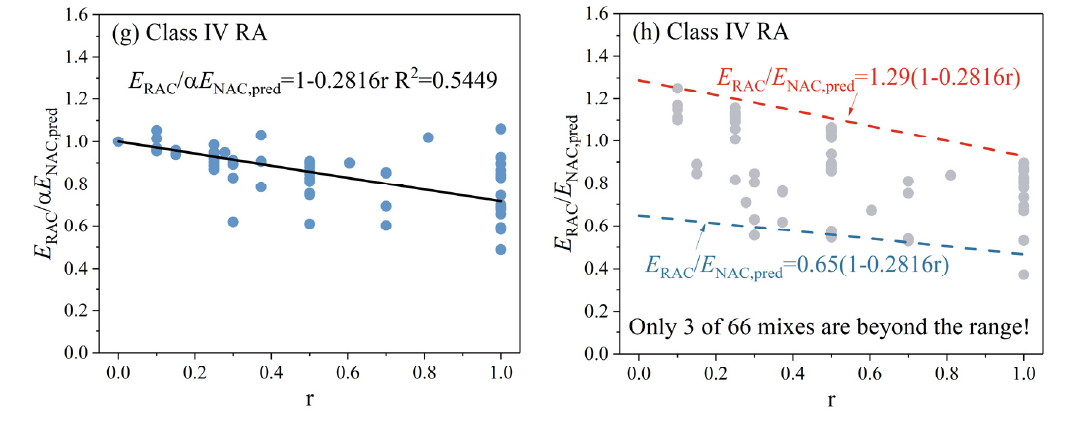
Figure 5. Relationships between E RAC / α E NAC,pred , E RAC / E NAC,pred and r of RAC [21,22,28–167,169–174]. ( a ) Relationship between E RAC / α E NAC,pred and r of Class I RAC; ( b ) relationship between E RAC / E NAC,pred and r of Class I RAC; ( c ) relationship between E RAC / α E NAC,pred and r of Class II RAC; ( d ) relationship between E RAC / E NAC,pred and r of Class II RAC; ( e ) relationship between E RAC / α E NAC,pred and r of Class III RAC; ( f ) relationship between E RAC / E NAC,pred and r of Class III RAC; ( g ) relationship between E RAC / α E NAC,pred and r of Class IV RAC; ( h ) relationship between E RAC / E NAC,pred and r of Class IV